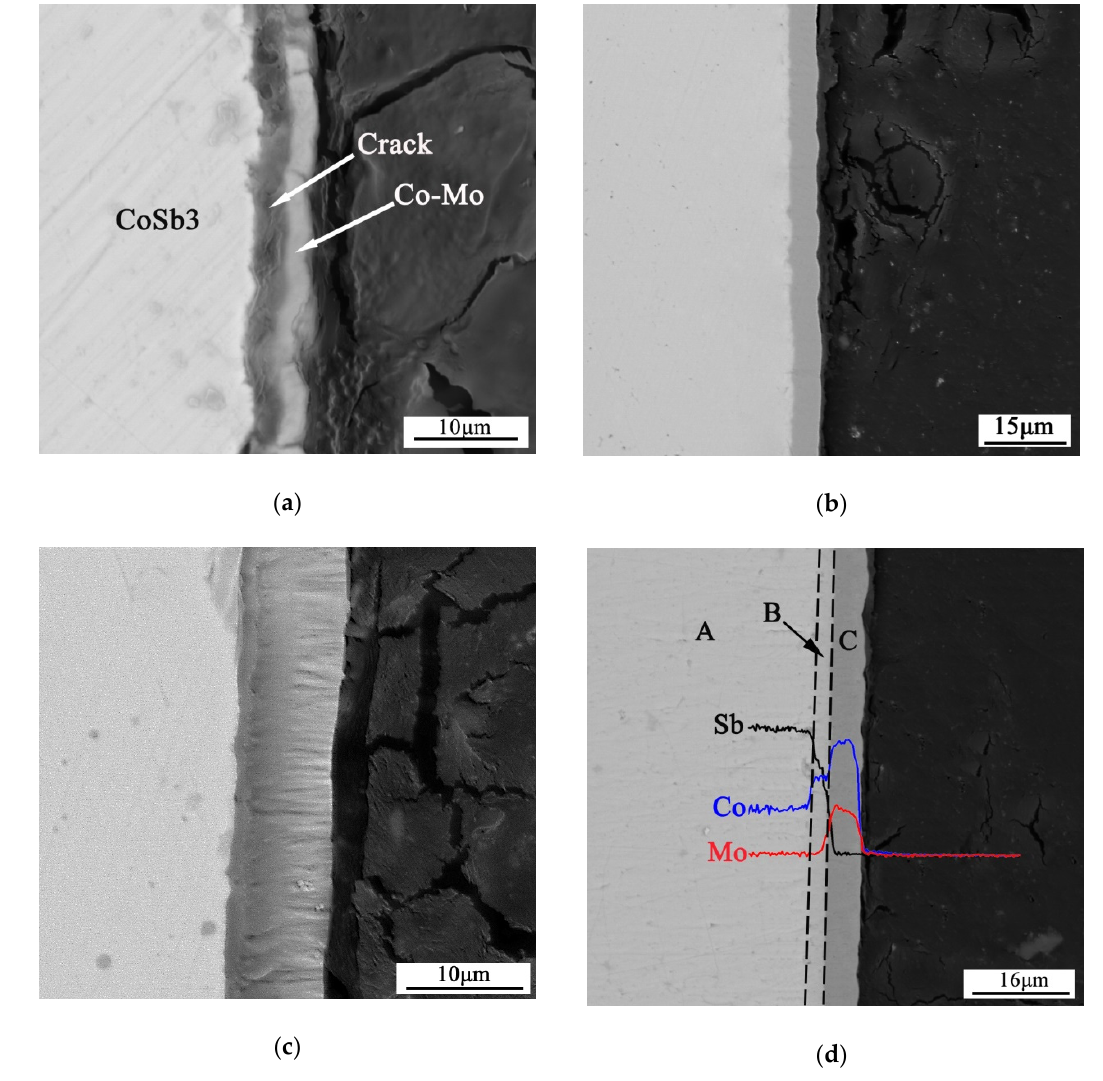
Figure 1. The backscattered electron (BSE) micrograph of Co-Mo/skutterudite (SKU) couple: ( a ) Before annealing, some parts of the electroplated barrier layer were separated from the skutterudite. ( b ) Annealed at 450 °C for 2 h, a metallurgical bonding between the barrier layer and the skutterudite compound was achieved. ( c ) The columnar crystals of the Co-Mo barrier layer. ( d ) The Co-Mo/SKU couple reacted at 500 °C for 5h. CoSb 2 of 3 μ m was formed between the electroplated layer and skutterudite compound.